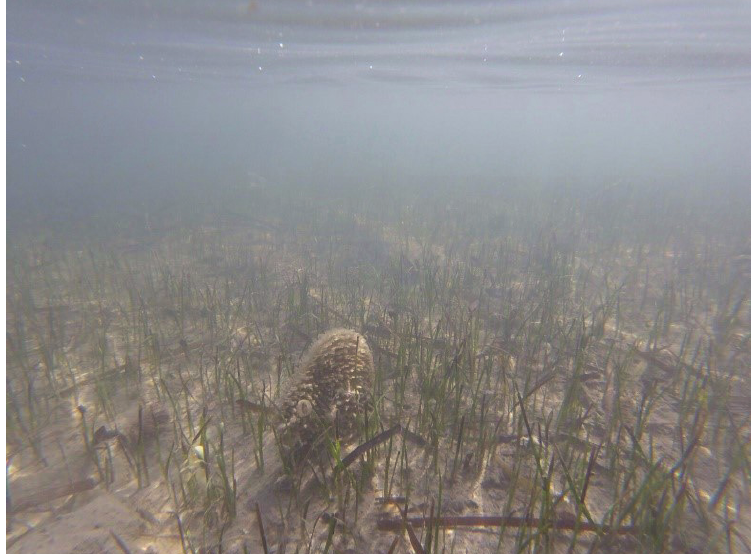
Figure 2. A specimen of Pinna nobilis in the Aquatina Lagoon (NATURA 2000 site “ Aquatina di Frigole ” IT9150003).